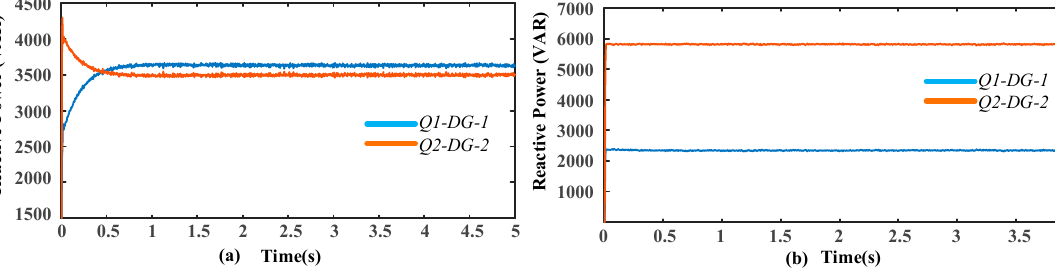
Figure 11. ( a ) Reactive power for the conventional control strategy; ( b ) reactive power for proposed control strategy.